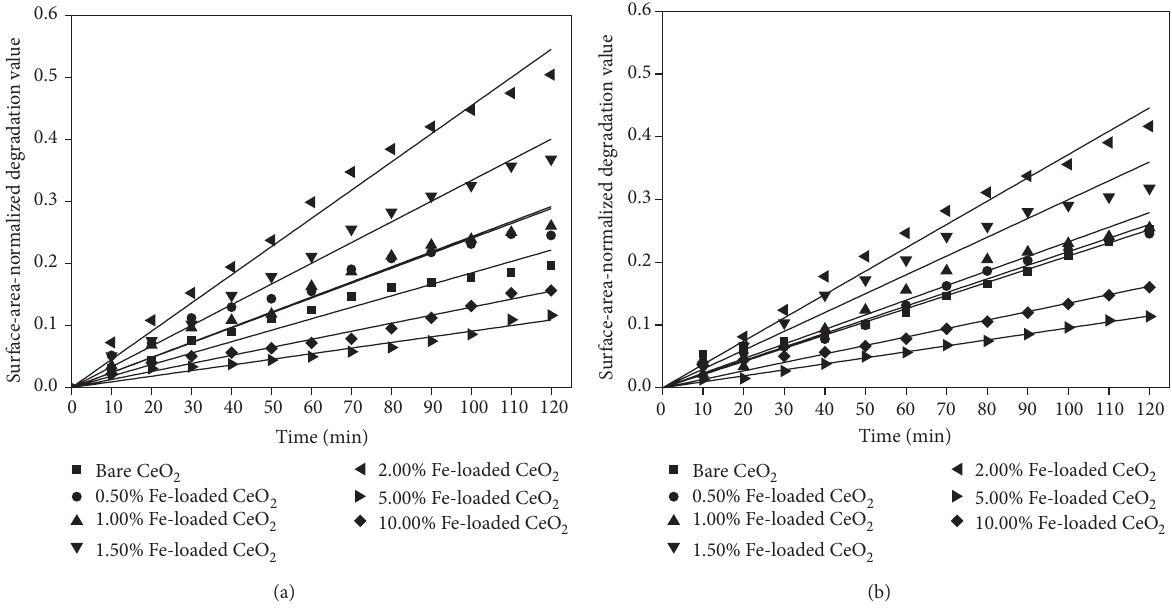
Figure 7: Kinetics plots of the surface-area-normalized degradation values against visible-light irradiation time for (a) formic acid and (b) oxalic